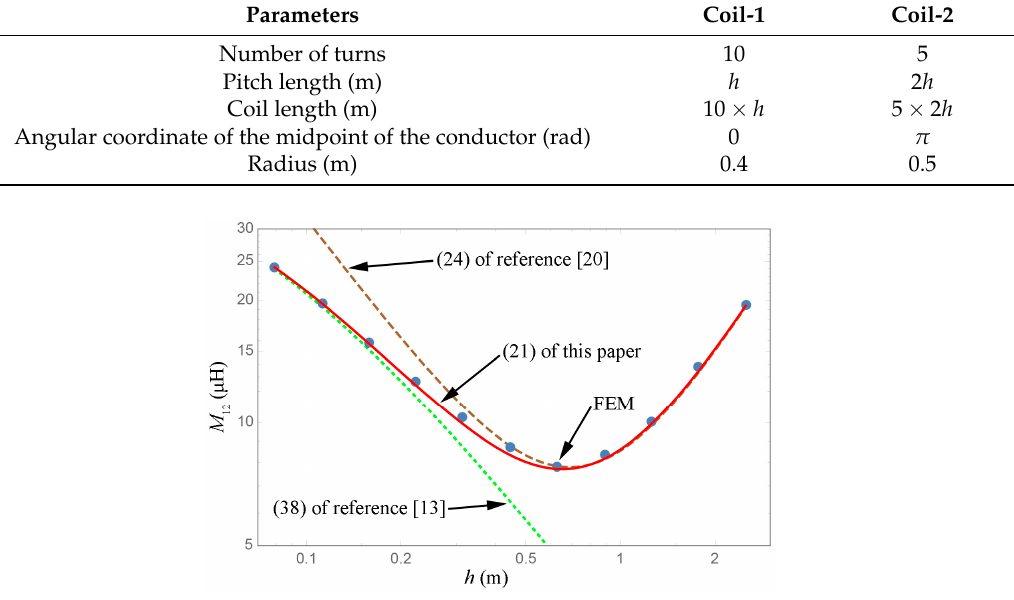
Figure 10. Pitch length ( h ) dependence of the mutual inductance (